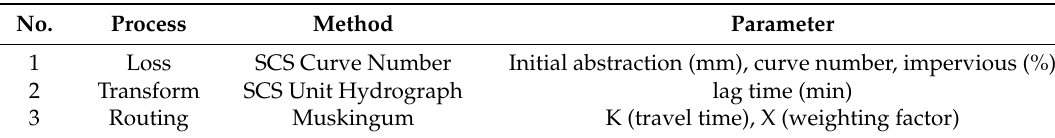
Table 2. HEC-HMS model